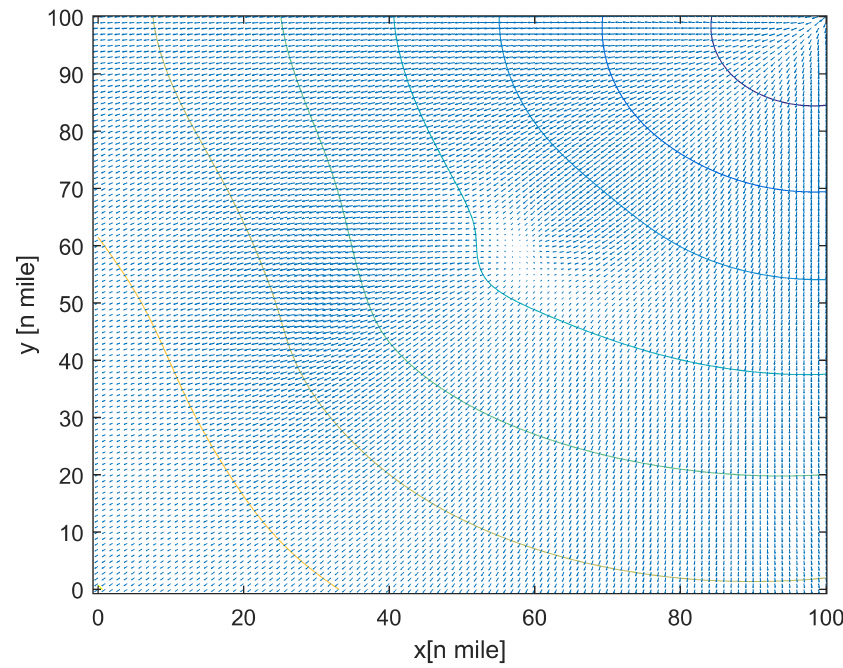
Figure 5. Map gradient and